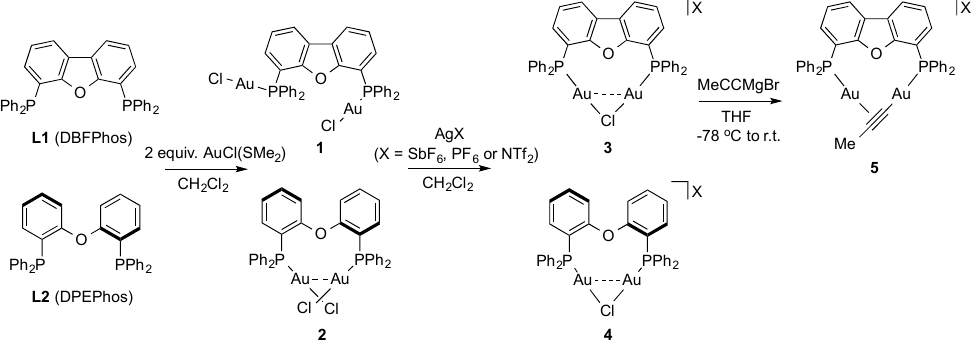
Scheme 1. Synthesis of well-defined Au 2 -complexes 3 – 5 from Au(I)–Au(I) precursors 1 and 2 , generated by reaction of ligands L1 and L2 with 2 equivalent of AuCl(SMe 2